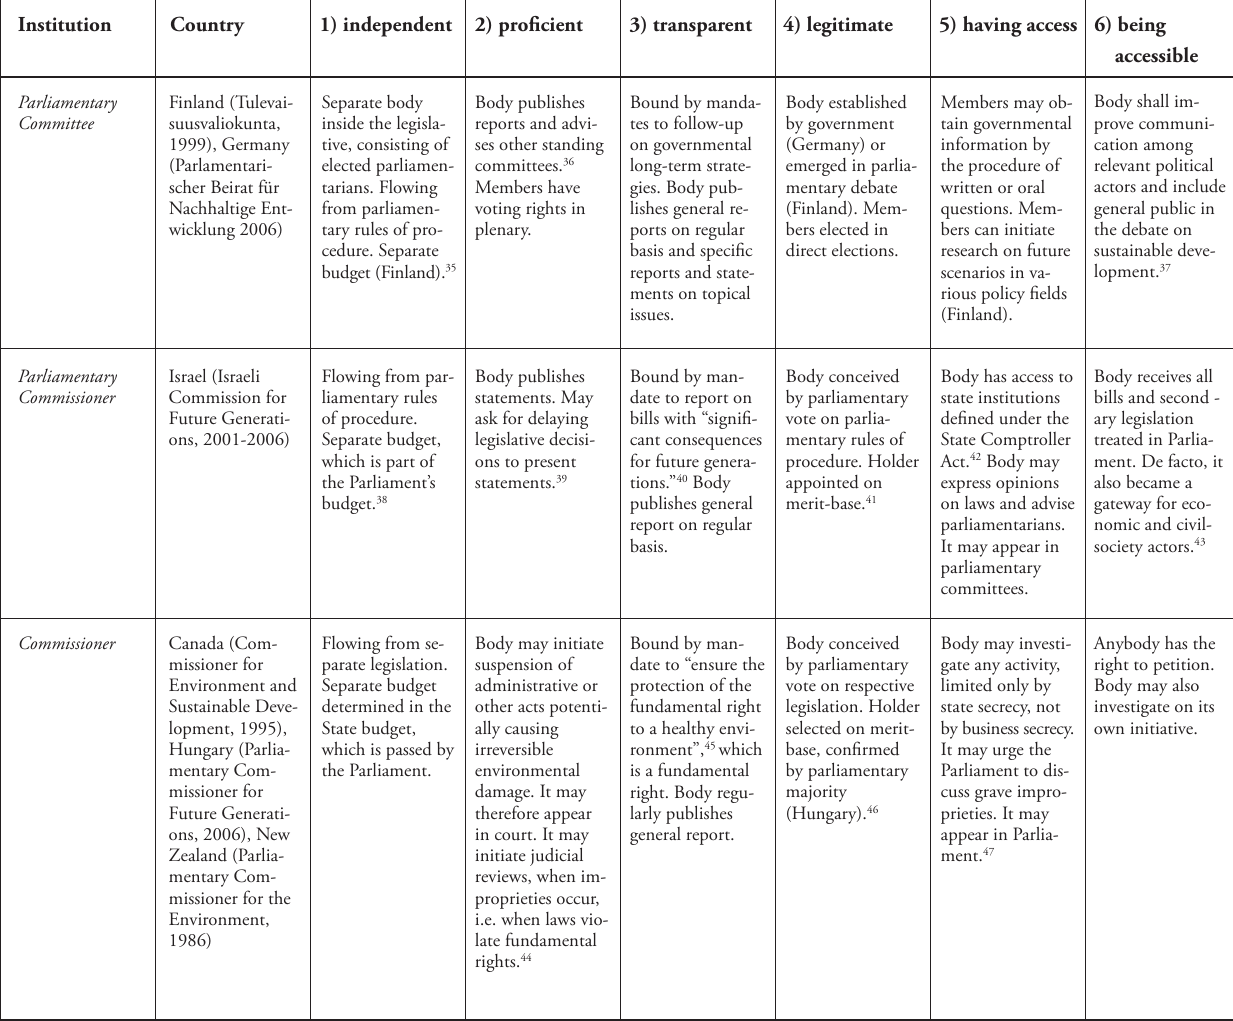
Table 1. Examples of institutional mechanisms of temporary checks and balances in